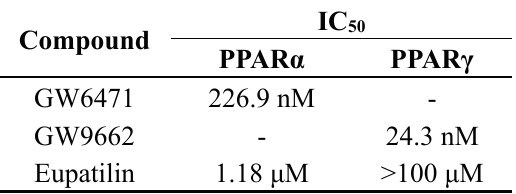
Table 1. Binding affinities of eupatilin for PPAR α and PPAR γ